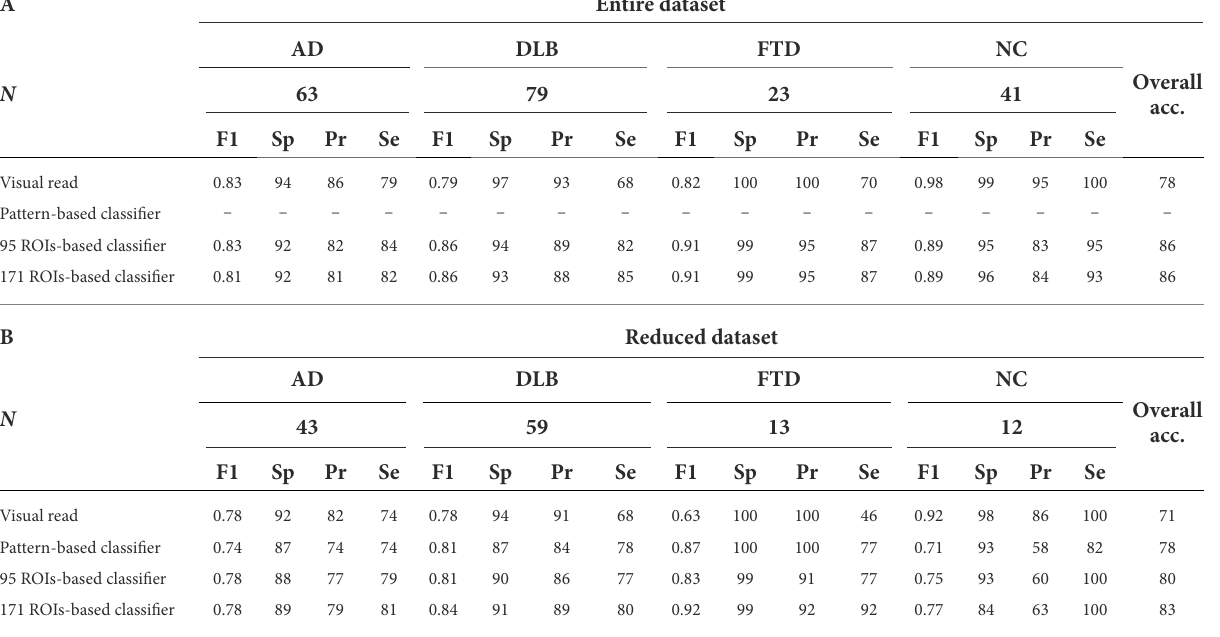
TABLE 2 Performance metrics for visual reading and the three machine learning